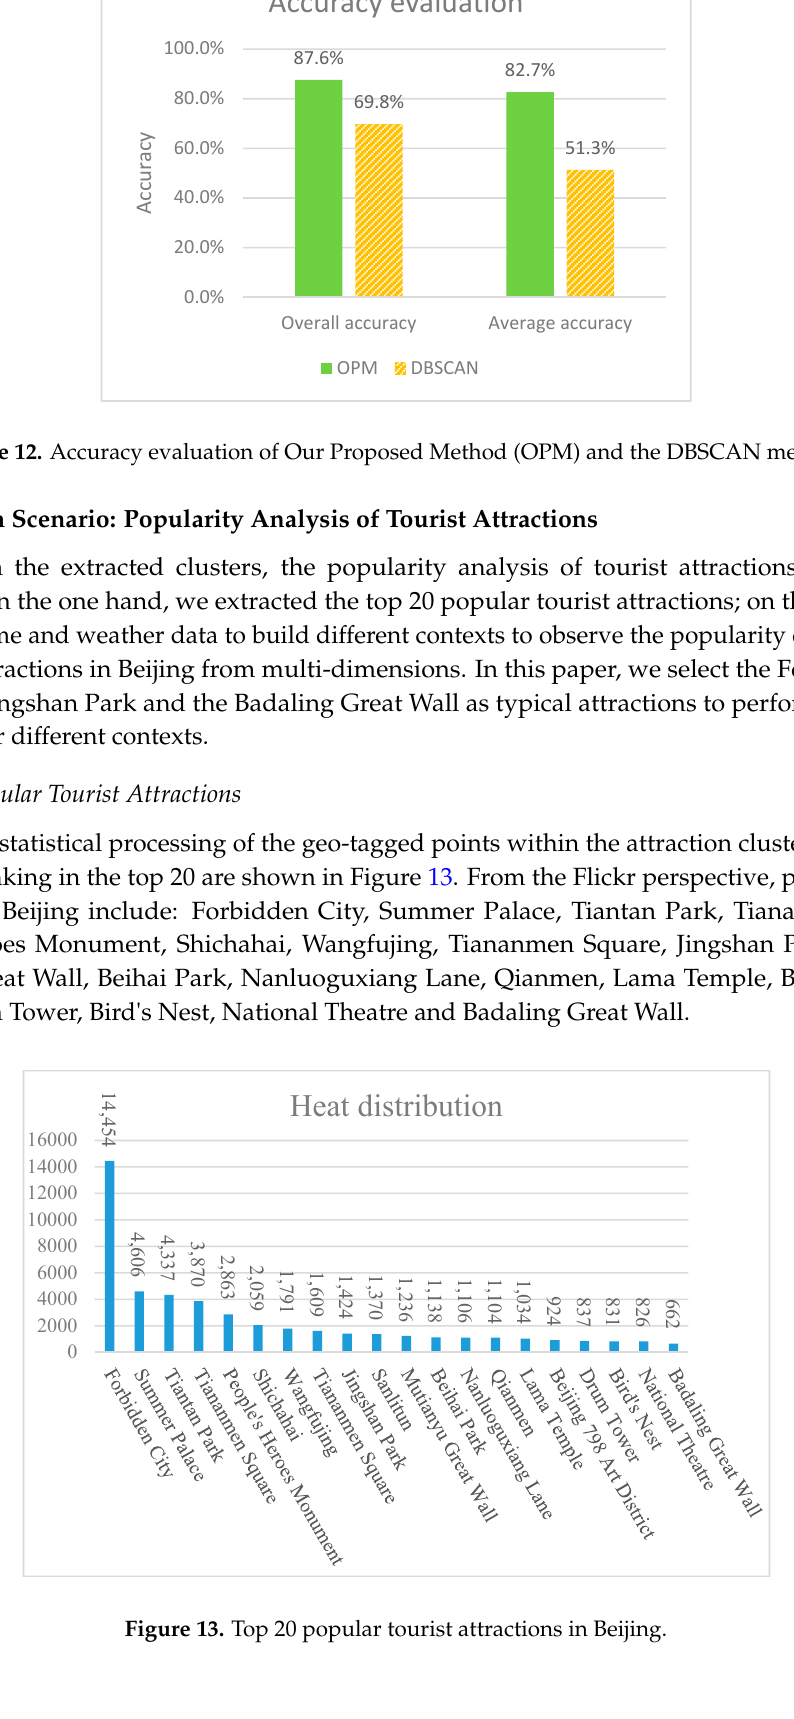
Figure 13. Top 20 popular tourist attractions in Beijing.